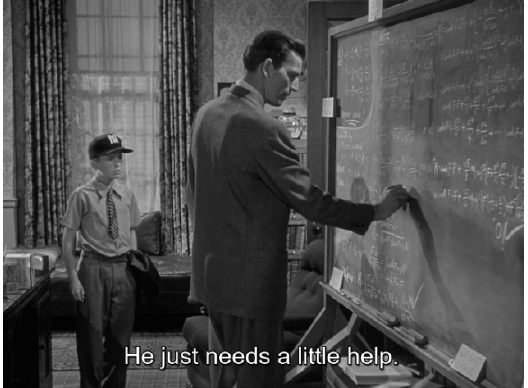
Figure 8. Klaatu correcting Prof. Barnhardt’s equation. The Day the Earth Stood Still © 20th Century Fox. All Rights Reserved. Fox. All Rights